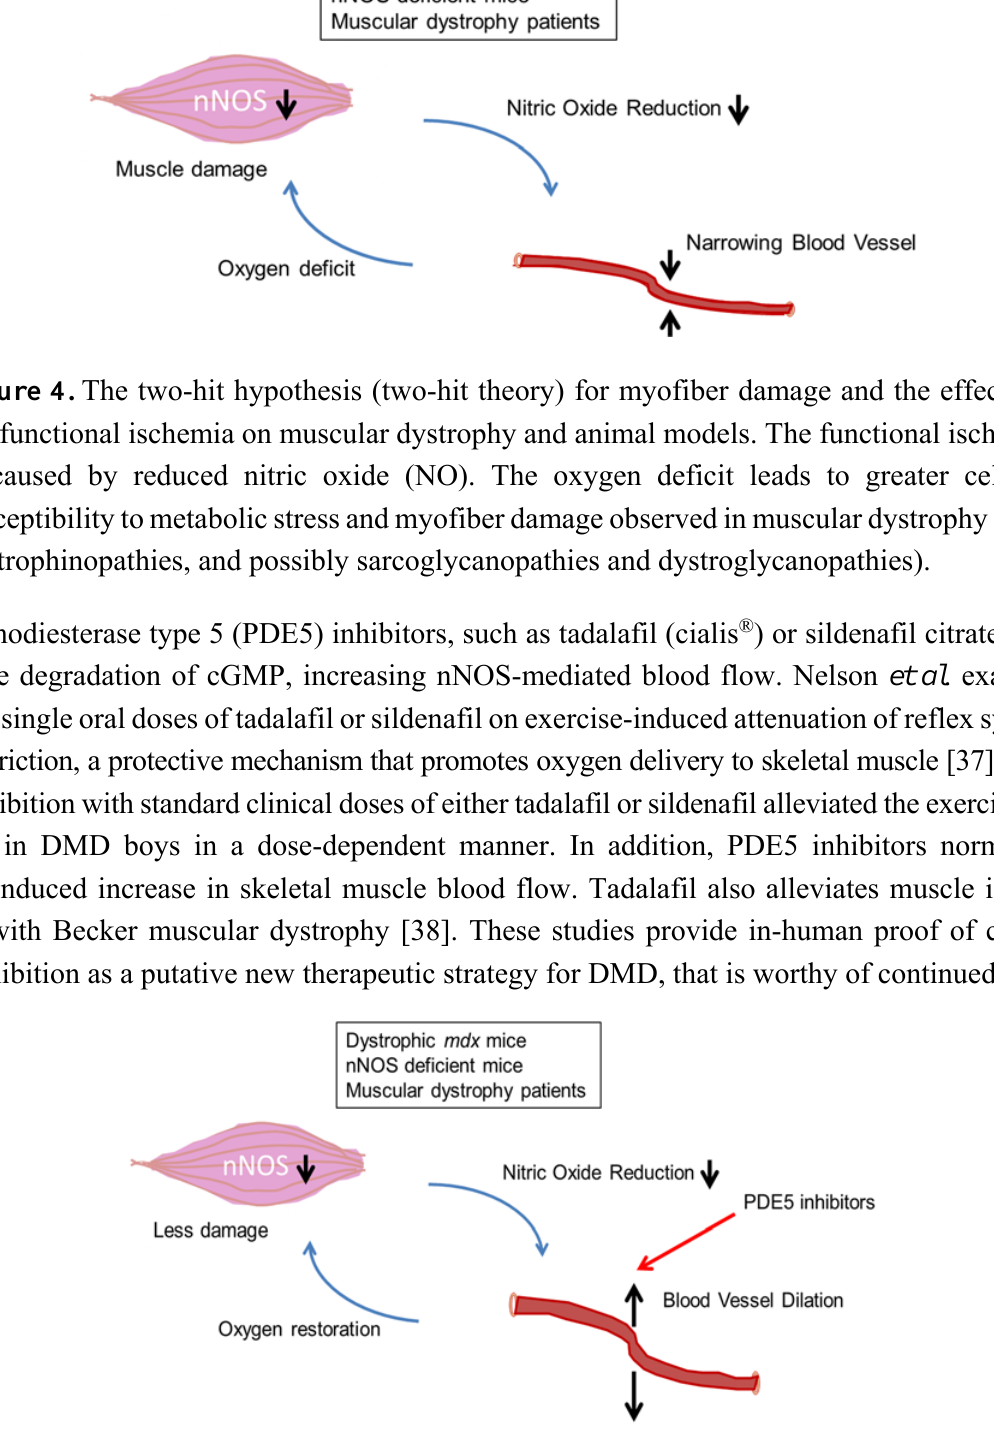
Figure 5. PDE5 inhibitors (e.g., Cialis and Viagra) increase the cyclic GMP levels in blood vessels that supply oxygen to skeletal muscles. PDE5 inhibitors are possibly effective for treating or preventing activity-induced fatigue and muscle damage in muscular dystrophy patients (e.g., dystrophinopathies, and possibly sarcoglycanopathies and